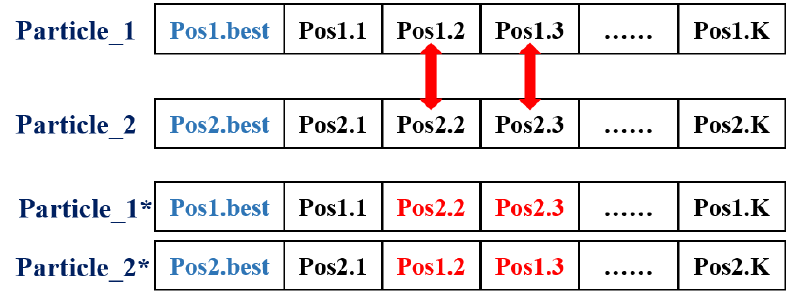
Figure 9. Bad fitness value particles in the swarm. Adopted from Wikipedia [57].